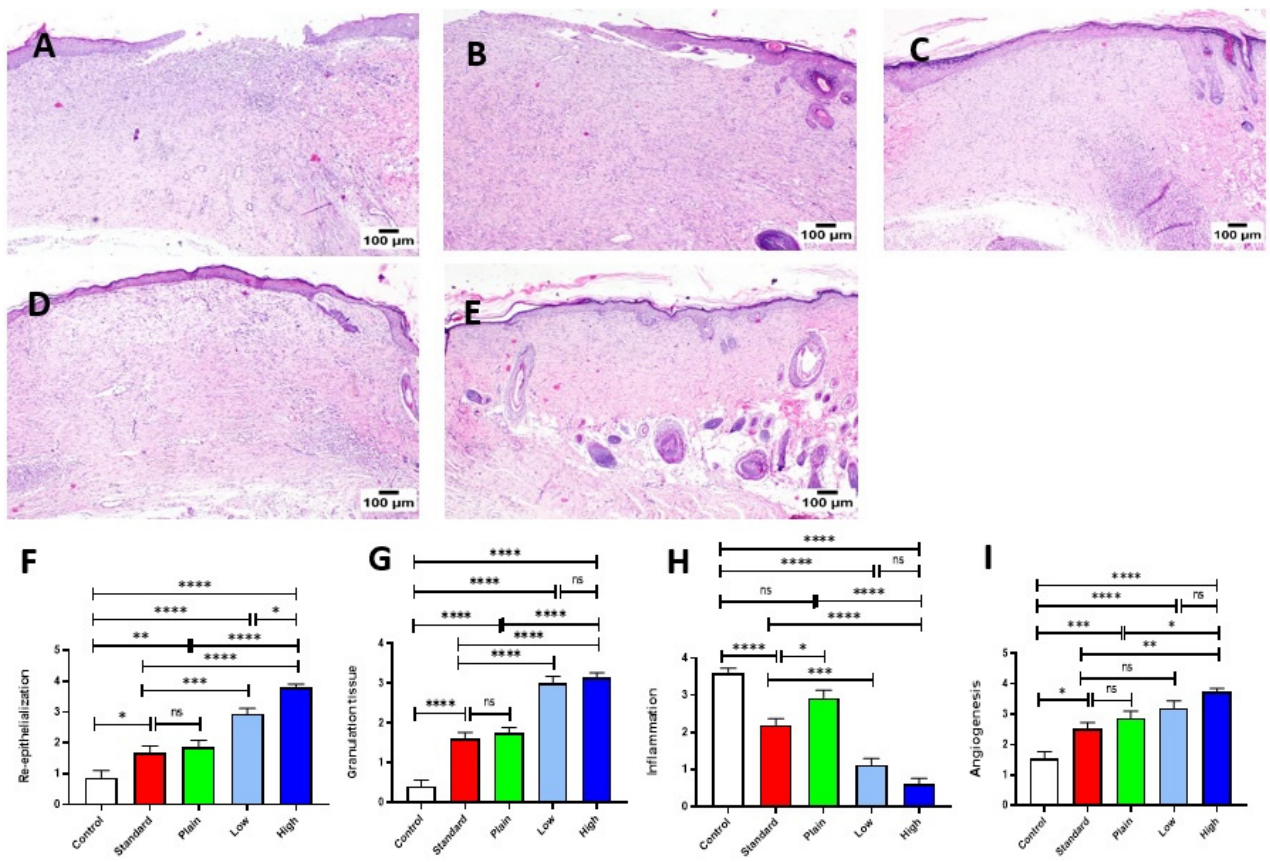
Figure 8. Histopathological examination of the healed tissue. Microscopic images of skin, HE stained ( A ) control group, ( B ) standard gentamicin (0.1% garamycin cream), ( C ) plain, ( D ) low, and ( E ) high. Charts, histopathological evaluation of ( F ) re-epithelization, ( G ) granulation tissue formation, ( H ) inflammation, and ( I ) angiogenesis. Data represented as mean ± SE of at least 5 wounds. **** for p < 0.0001, *** for p < 0.001, ** for p < 0.01, * p < 0.05, ns for non ‐ significant.